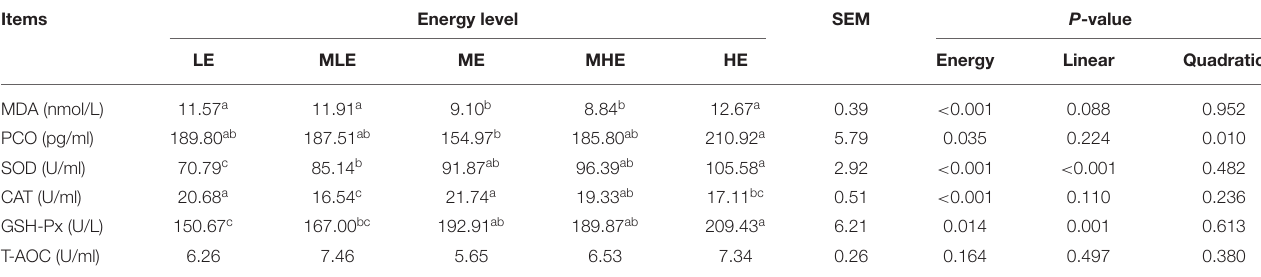
TABLE 3 | The effects of dietary energy level on oxidative injury of Yunnan semi-fine wool sheep. Items Energy level SEM P -value LE MLE ME MHE HE Energy Linear Quadratic MDA (nmol/L)